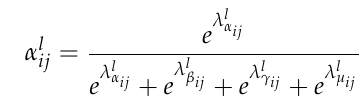
Threshold map Figure 5. The flow chart of textbox inference. The segmentation of text area and background noise is essentially a binary classifica- tion task. When binary cross-entropy is used as its classification loss, the DB function is shown in Equation (5):